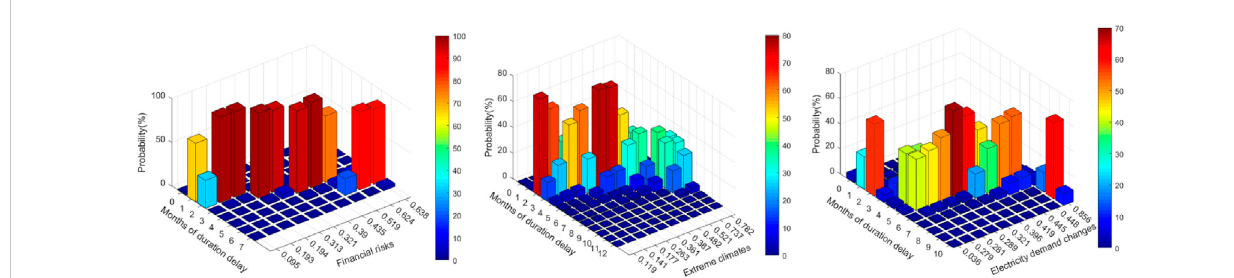
FIGURE 1 Occurrence probability distributions of infrastructure project delay under different risk